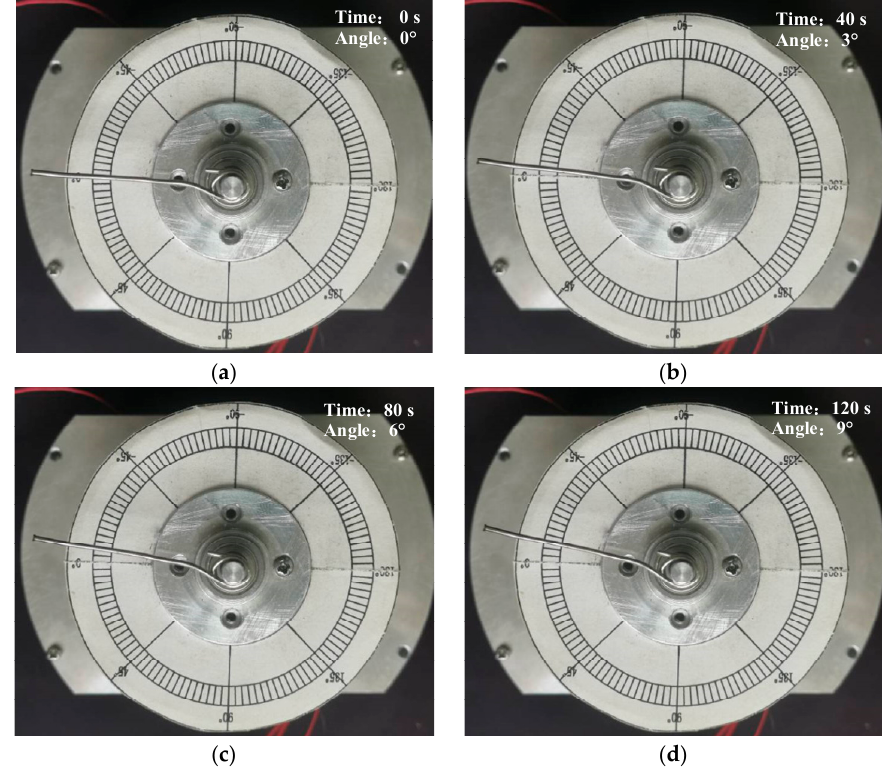
Figure 18. Experimental effect when the phase difference α is 50°. ( a ) At 0 s; ( b ) at 40 s; ( c ) at 80 s; ( d ) at 120 s.